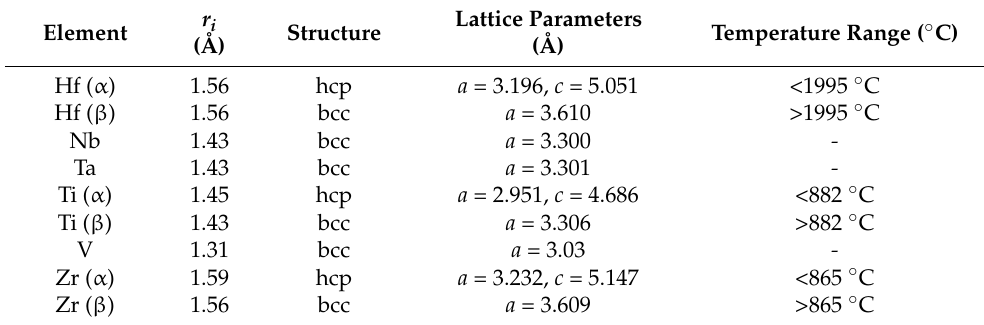
Table 2. Atomic radii r i , equilibrium structure and lattice parameters of refractory metals Hf, Nb, Ta, Ti, V, and Zr. The table contains data for both allotropic phases for Hf, Ti, and